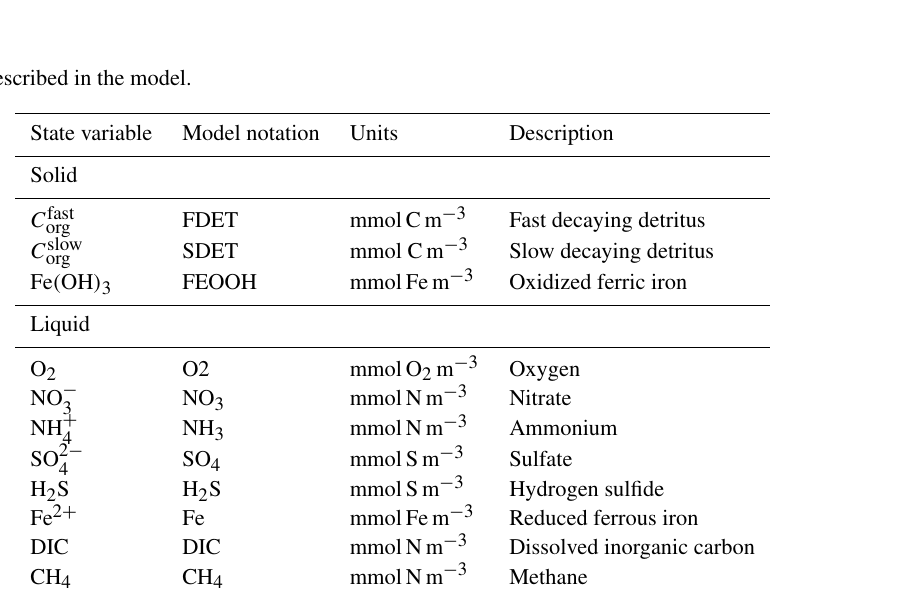
Table 2. State variables described in the